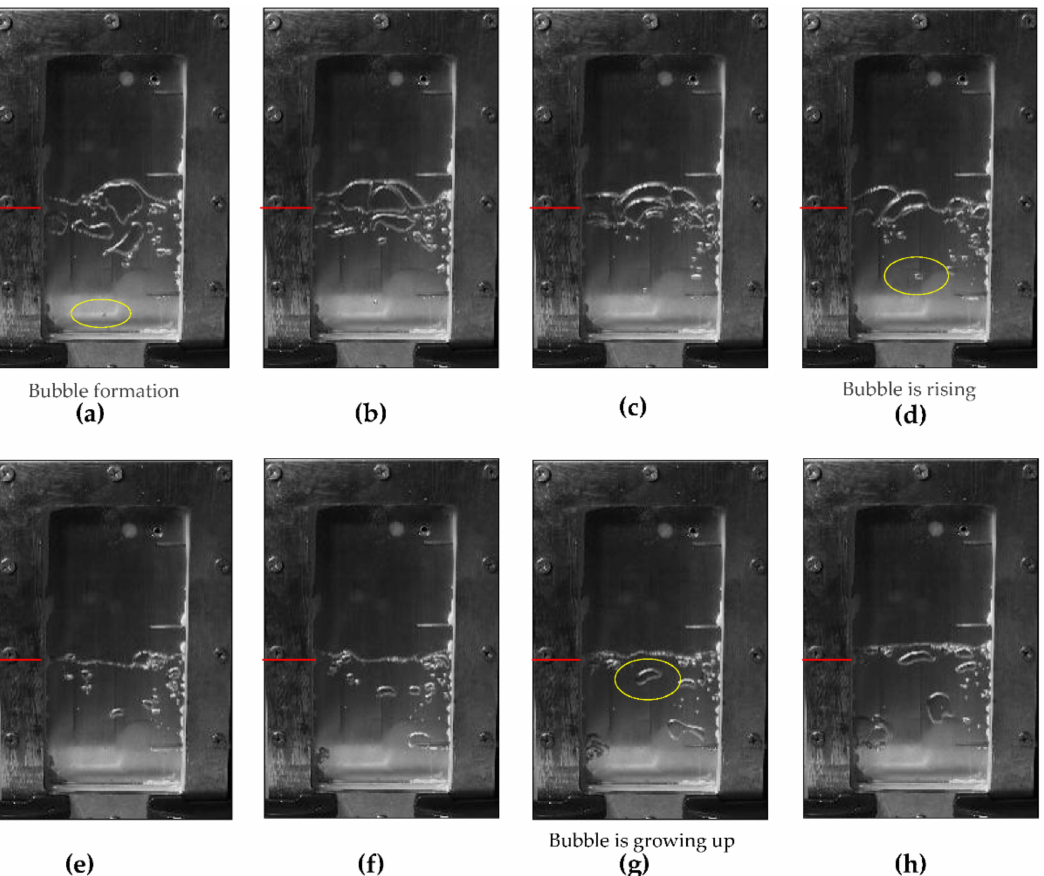
Figure 17. Time-series diagram of homogeneous nucleation and bubble growth in the evaporation section of the PGHP (FR = 48%, Q in = 80 W, ∆ t = 60 ms). Note: the initial level is shown as the red line, ( a )